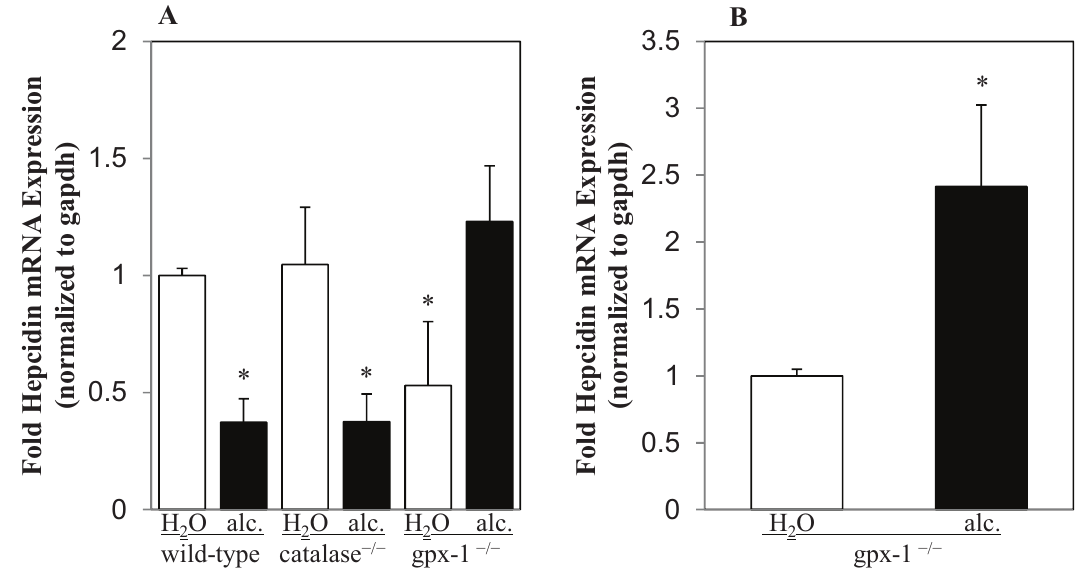
Figure 2. Hepcidin mRNA expression in the liver. cDNA synthesized from liver RNA of transgenic mice, lacking the expression of either glutathione peroxidase-1 (gpx-1 (cid:2)/(cid:2) ) or catalase (catalase (cid:2)/(cid:2) ), and wild-type mice, fed with plain water (H 2 O) or ethanol (alc.), was employed to determine hepcidin mRNA expression by Taqman real-time PCR. ( A ) Hepcidin gene expression in water or alcohol-fed transgenic mice and alcohol-fed wild-type mice was expressed as-fold hepcidin expression of that in wild-type mice fed with water. ( B ) Hepcidin gene expression in alcohol-fed gpx-1 (cid:2)/(cid:2) mice was expressed as-fold hepcidin expression of that in gpx-1 (cid:2)/(cid:2) mice fed with water. Asterisks indicate statistical significance ( p <